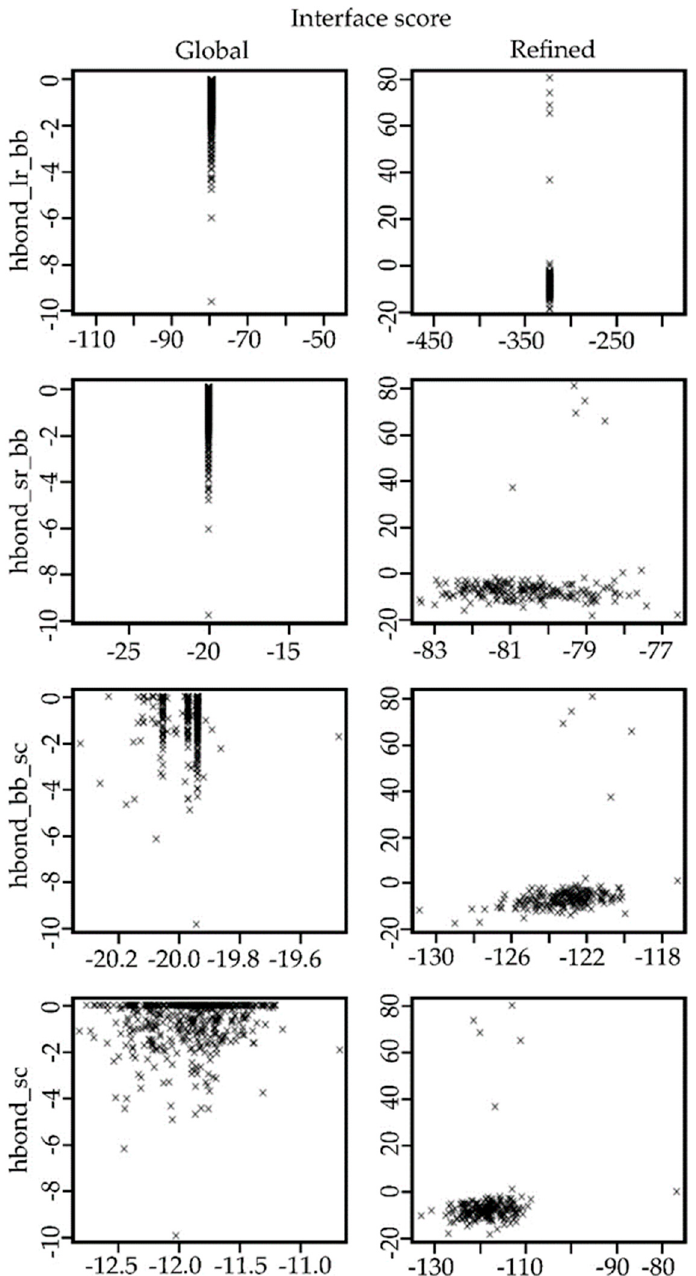
Figure 5. Comparison of different terms in the score file registered for the complexes created using the global protein–protein protocol versus the values obtained for the models created using the FlexPepDock protocol. hbond_lr_bb = energy of long-range hydrogen bonds (kcal/mol), hbond_sr_bb = energy of short-range hydrogen bonds (kcal/mol), hbond_bb_sc = energy of backbone–side-chain hydrogen bonds (kcal/mol), and hbond_sc = energy of side-chain–side-chain hydrogen bonds (kcal/mol). For the refined complexes between the LPS–FhuA and Ib-M6 peptide models, multiple possible hydrogen bonds are found in each complex (Table